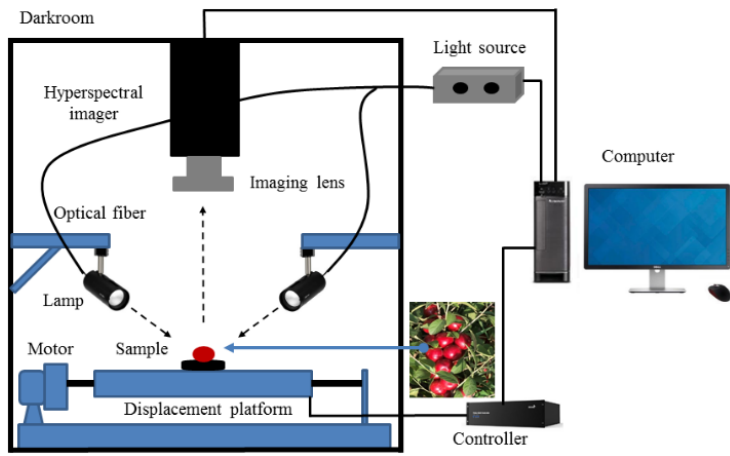
Figure 2. Experiment platform of hyperspectral imaging